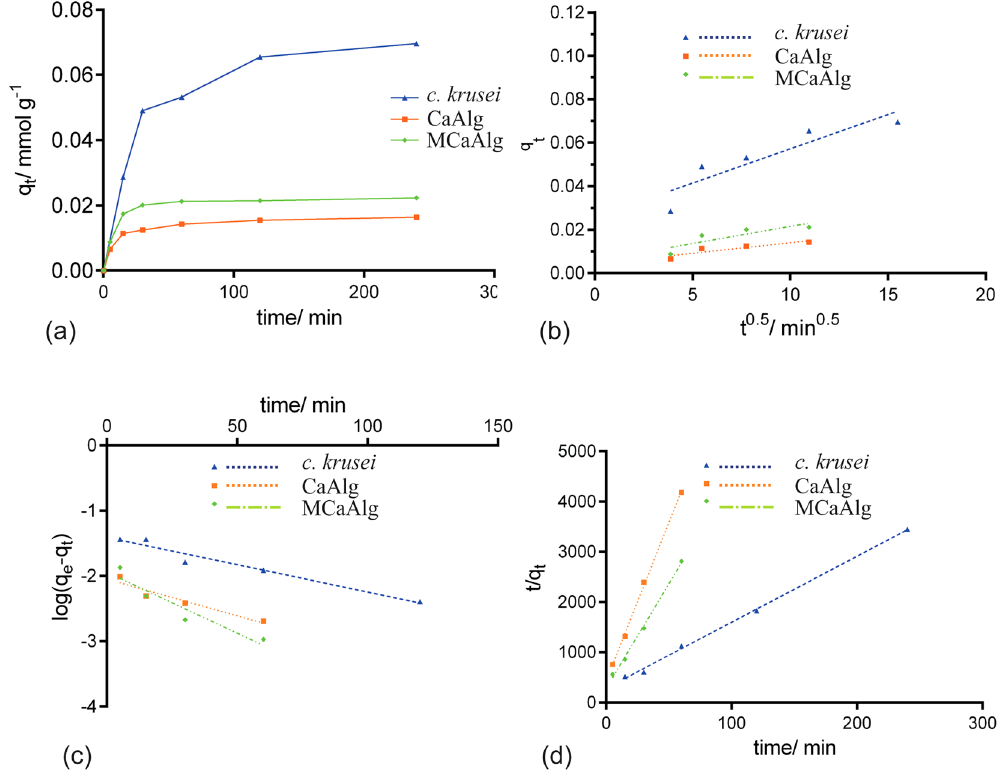
Figure 5. Kinetics studies on copper(II) removal ( a ) with C . krusei , CaAlg and MCaAlg ( b ) Intraparticle diffusion modelling ( c ) Pseudo-first-order modelling ( d ) Pseudo-second-order modelling.